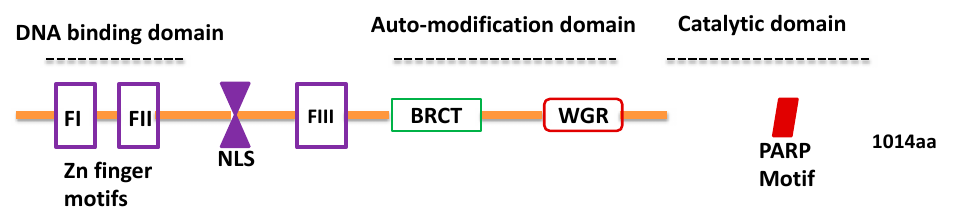
Figure 1. Structure of Poly (ADP)-ribose polymerase-1 (PARP-1). The N terminus of PARP-1 contains the DNA-binding domain (DBD) constituting two zinc-finger motifs and a bipartite nuclear localization signal (NLS). The auto-modification domain constitutes a breast cancer (BRCA) C-terminus-like (BRCT) interaction domain and the Tryptophan-Glycine-Arginine (WGR) domain that mediates interactions with self or protein partners. PARP-1 has a catalytic domain at its C’ terminus, within which is contained its Poly (ADP)-ribosylation polymerase (PARP) signature motif that catalyzes Poly (ADP)-ribosylation (i.e., PARylation) reactions using intracellular nicotinamide adenine dinucleotide (NAD+) as a donor of ADP-ribose.